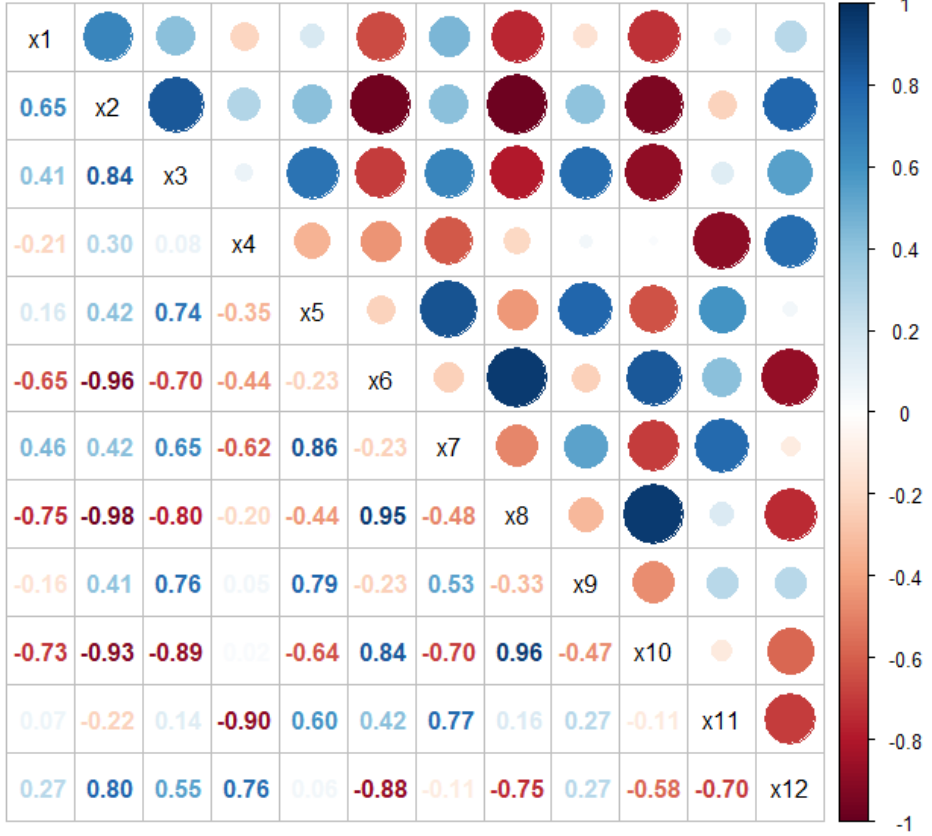
Figure 1. Correlogram of the 12 morphometric characters.